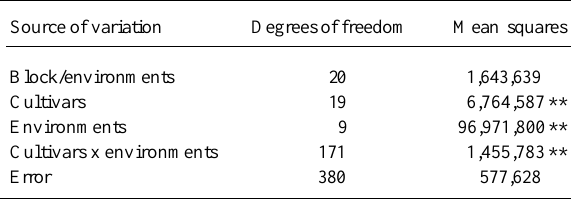
Table II - Joint analysis of variance for the yield (kg/ha) of 20 maize cultivars in 10 environments. Source of variation Degrees of freedom Mean